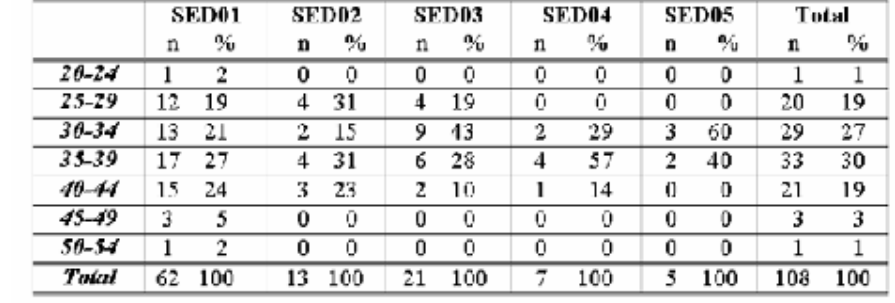
Table 2. Student dropout rates by Age Group and by Study Module